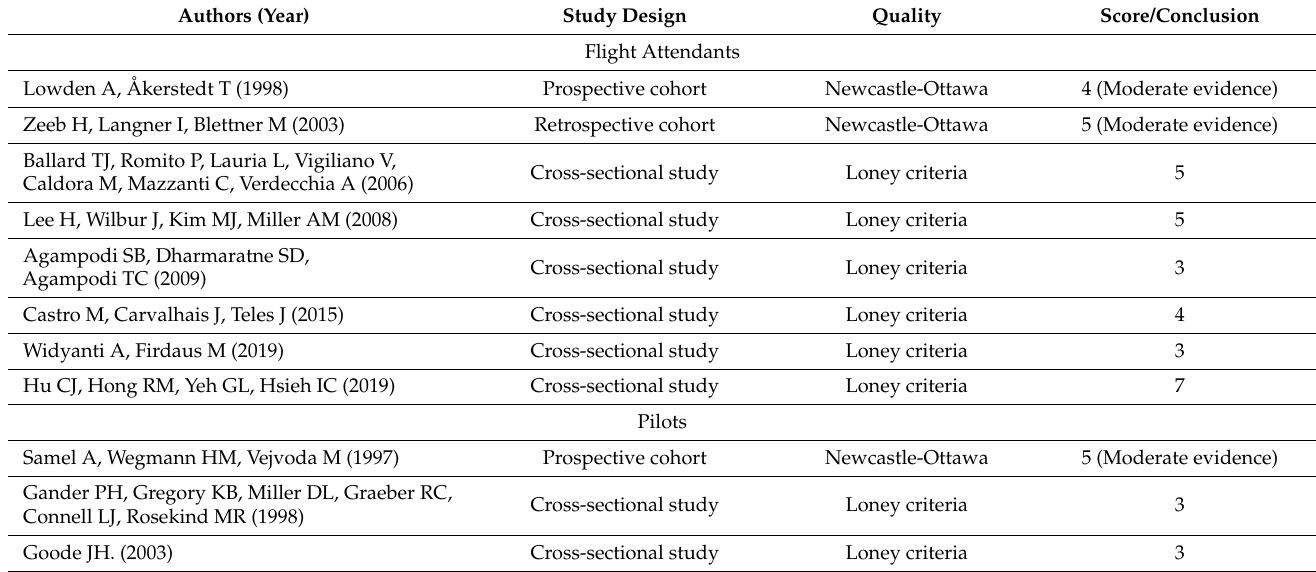
Table 6. Risk of bias of studies assessed by Newcastle-Ottawa tool or Loney criteria, according to study